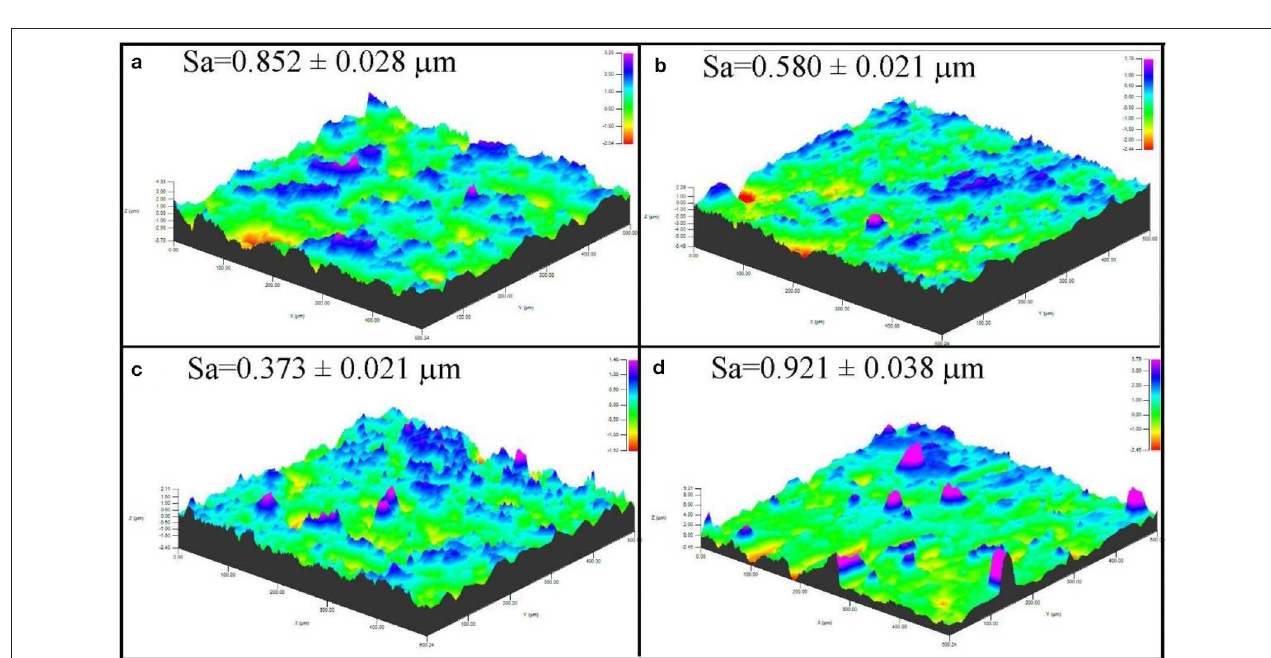
FIGURE 4 | Three-dimensional profile of HAPC-treated specimens: (a) S1, (b) S2, (c) S3, and (d) S4.